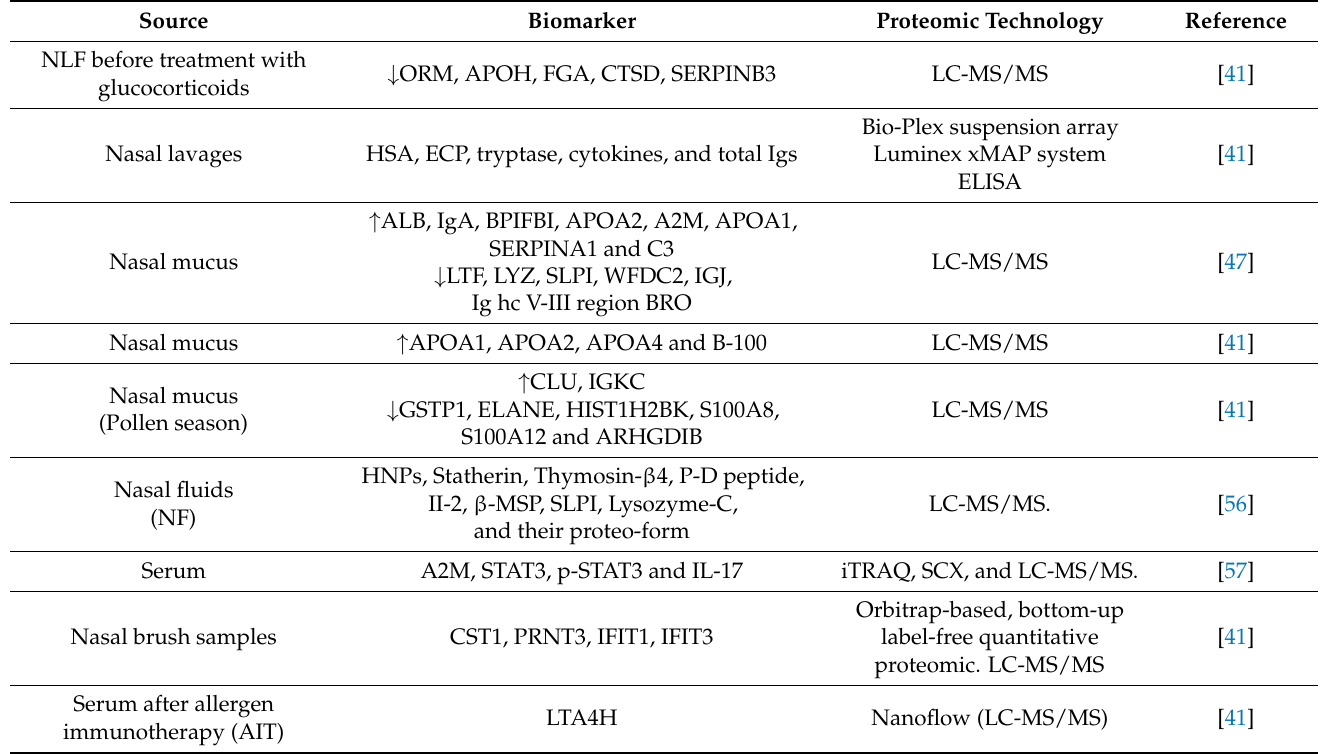
Table 1. A non-exhaustive list of current proteomics technologies for Allergic Rhinitis diagnosis. Up arrows indicate up-regulated proteins; meanwhile, down arrows show down-regulated